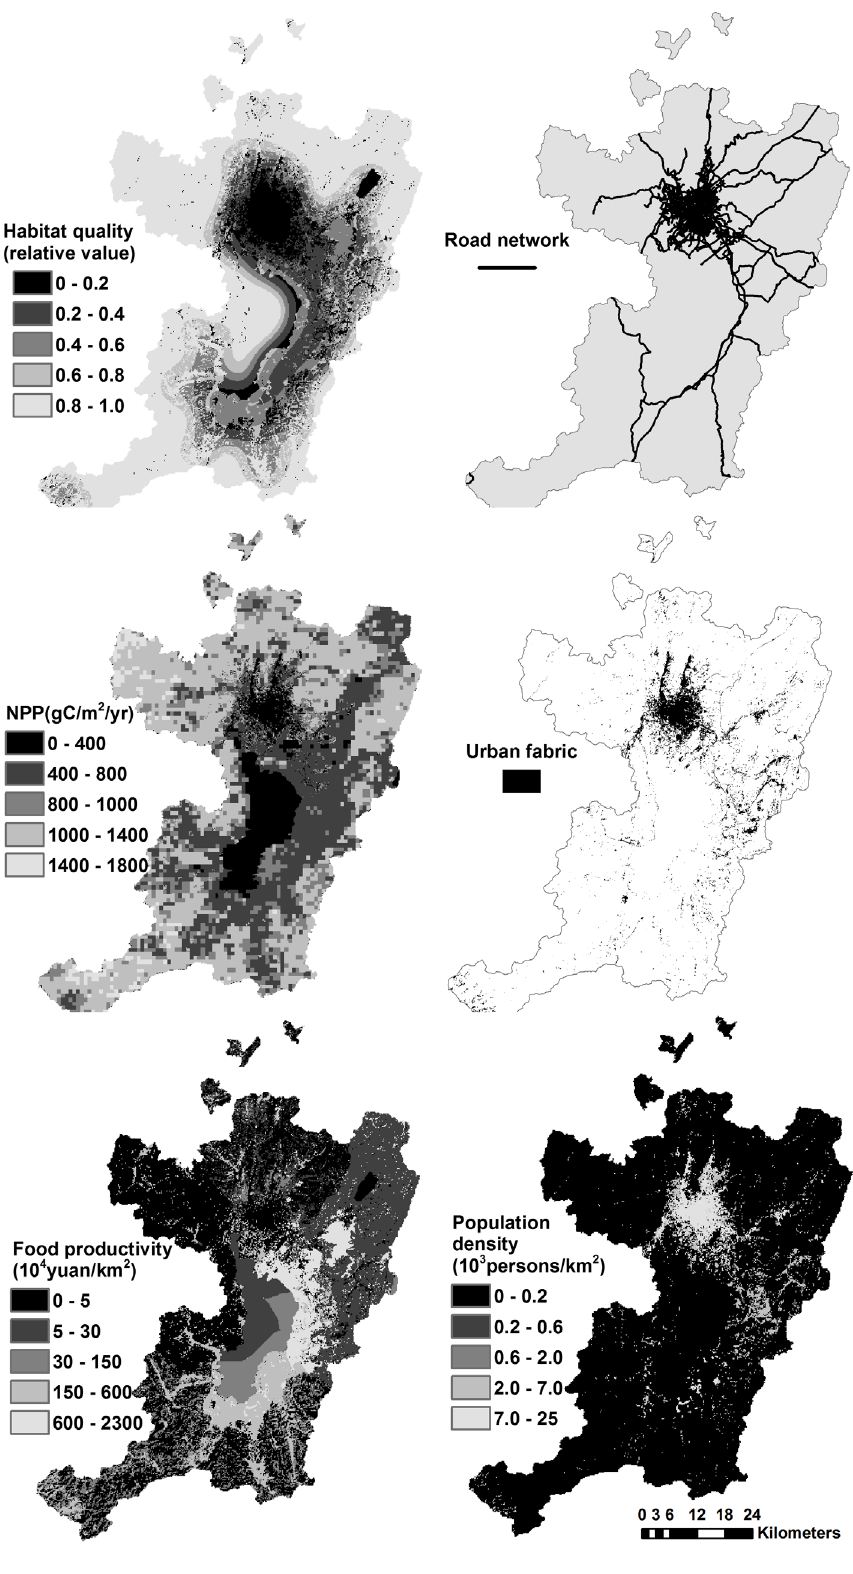
Figure 8: Spatial distributions of the three ecosystem services (left column) and the three socioeconomic items (right column) in the Kunming urban-rural area. NPP data are for 2006, road network relates to 2007 and the other four item are for